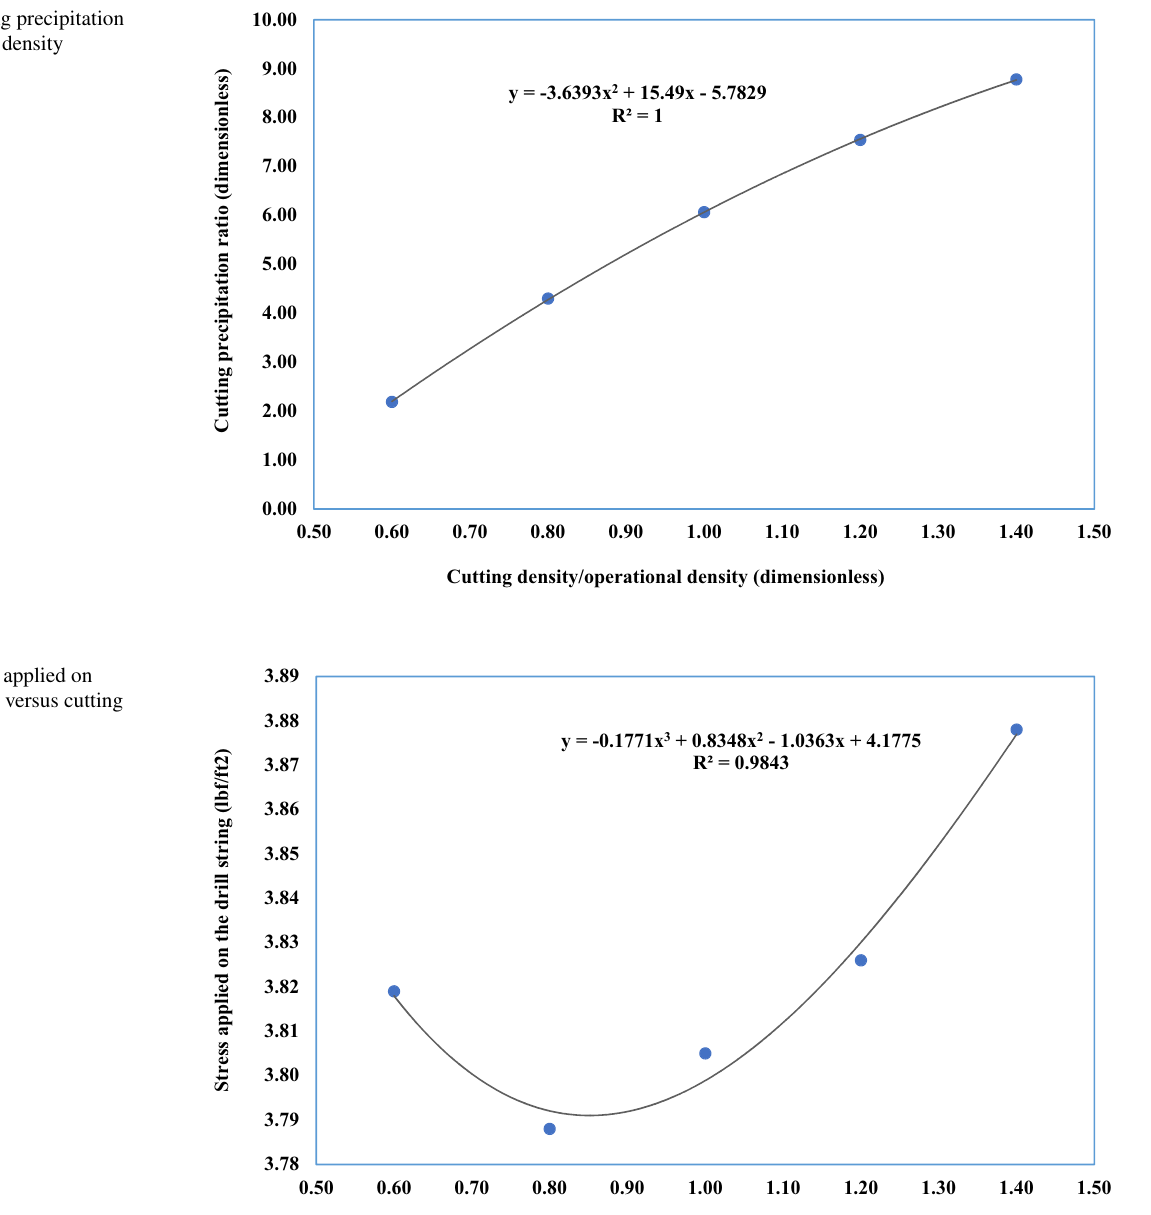
Fig. 20 Cutting precipitation versus cutting density